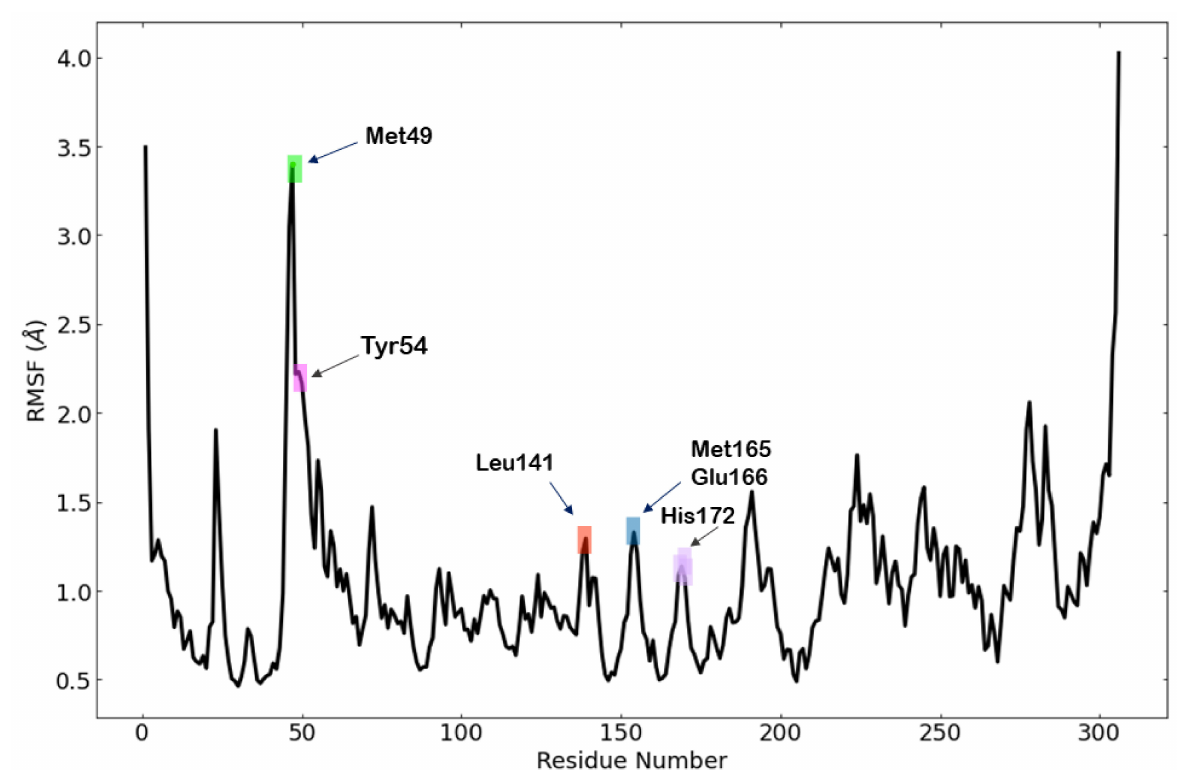
Figure 14. Per residue, RMSF for M pro in the MD run.